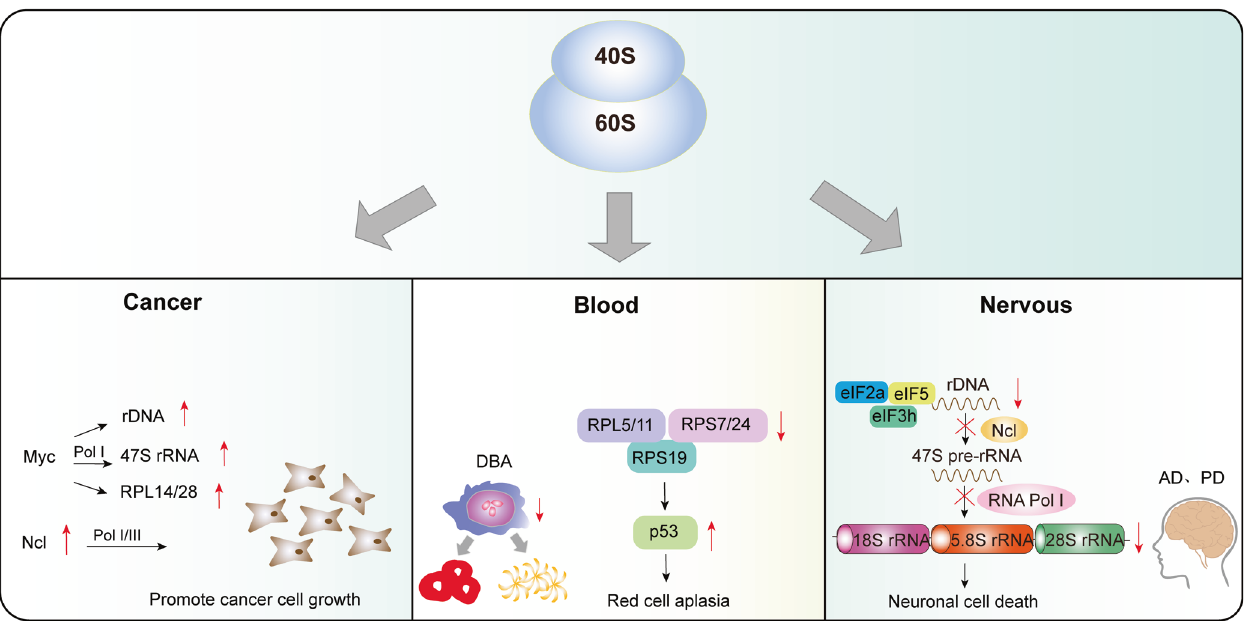
Fig. 8 Ribosome and human diseases. Abnormally active ribosome biogenesis is critical for cancer cell growth. The oncogene Myc upregulates rDNA transcription, activates RNA pol I-mediated 47S pre-rRNA synthesis, and induces the expression of RPL14 and RPL28 to stimulate ribosome biogenesis. In addition, Ncl enables cancer cells to differentiate and grow inde fi nitely by increasing the RNA Pol I activity. Blood diseases are associated with abnormal expression of RPs. RPL5/11 and RPS7/24 dysfunction and mutations in RPS19 activate p53, leading to a decline or even disappearance of erythroid cells, increasing the risk of malignant transformation. Ribosome dysfunction disrupts neuronal and glial homeostasis. Abnormal rDNA transcription affects the subsequent processing of 47S pre-rRNA into mature 5.8S, 18S, and 28S rRNA, disrupting rRNA synthesis and nucleolar integrity, and ultimately inducing neuronal cell death. Myc myelocytomatosis oncogene, Ncl nucleolin, rDNA ribosomal DNA, rRNA ribosomal RNA, RNA pol Ι RNA polymerase